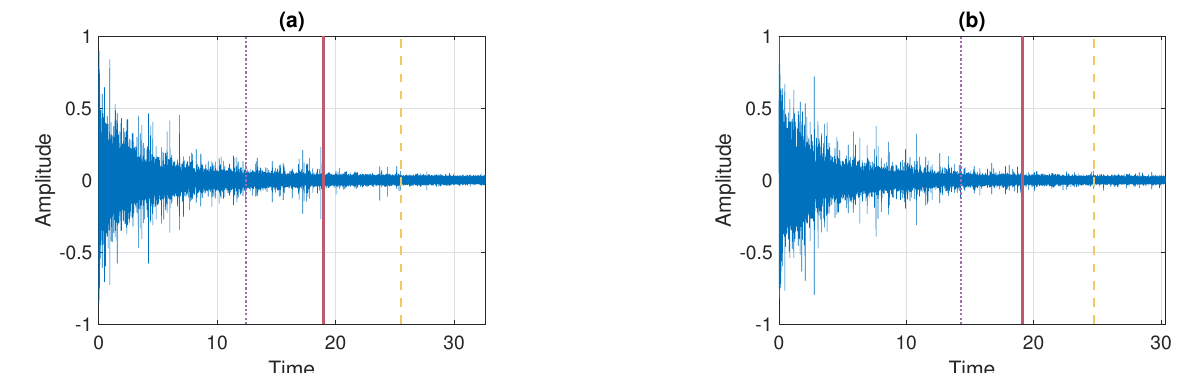
Figure 9. Signals with marked regime changes. The first change is visible as a dotted purple line, second: a solid red line, and the last one is a dashed yellow line. Panel ( a ) corresponds to Signal 1 and panel ( b ) corresponds to Signal 2.